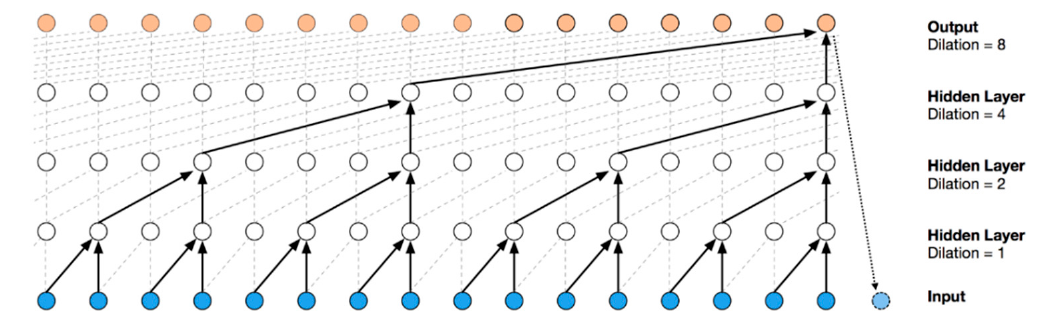
Figure 7. Architecture of a stack of dilated causal convolutional layers